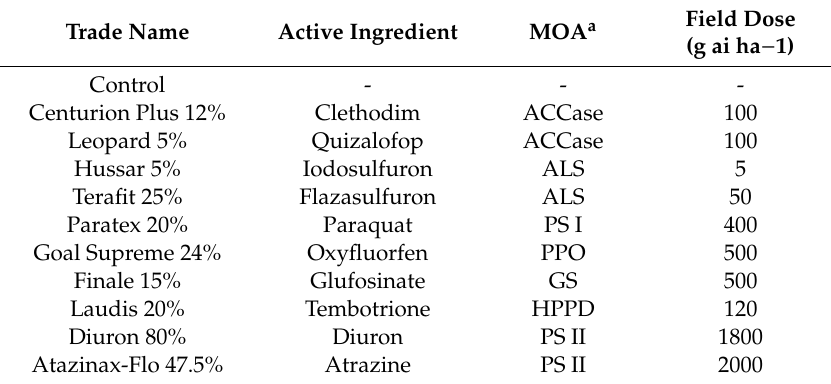
Table 1. Herbicides, active ingredients, mode of action (MOA), and dose (in g ai ha − 1 ) applied on C. distichophylla